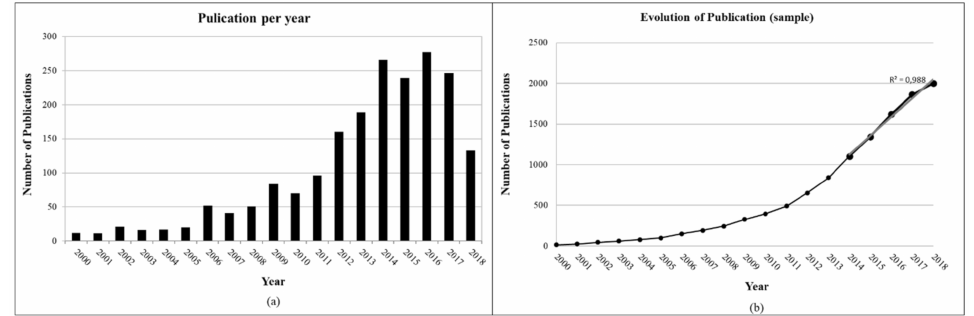
Figure 4. Frequency distribution of publications addressing Building Energy Efficiency. ( a ) Discrete, ( b ) cumulative (source: